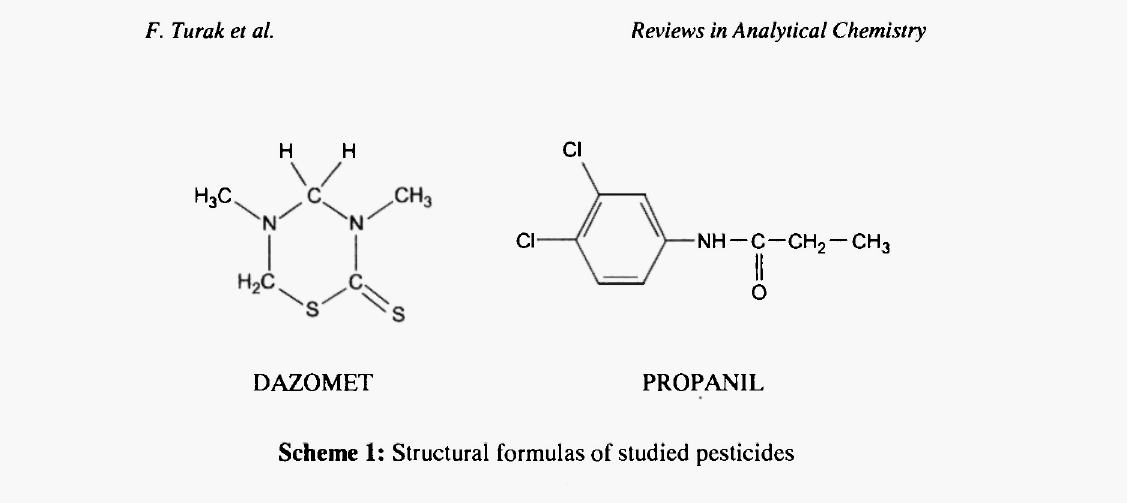
Scheme 1: Structural formulas of studied